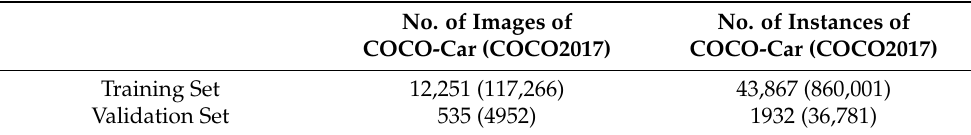
Table 2. Distribution of the fine-grained recognition dataset. Table 3. Distribution of the COCO-car